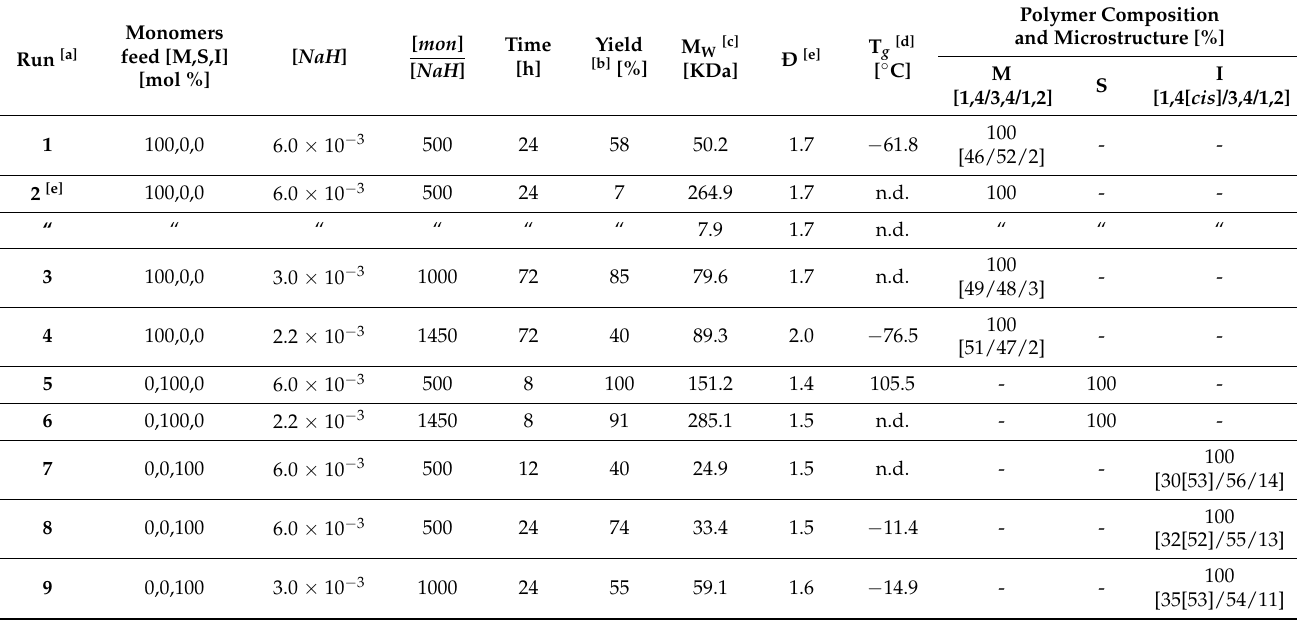
[a] Reactions were performed in toluene; (monomers) = 3.0; Al/Na = 0.8; tetrahydrofuran (THF)/Na = 50. [b] Conversion was determined by gravimetry. [c] Determined by size exclusion chromatography (SEC) in THF at 40 ◦ C, calibrated with polystyrene standards. [d] Determined by DSC. [e] THF/Na = 0. N.d. = not determined.